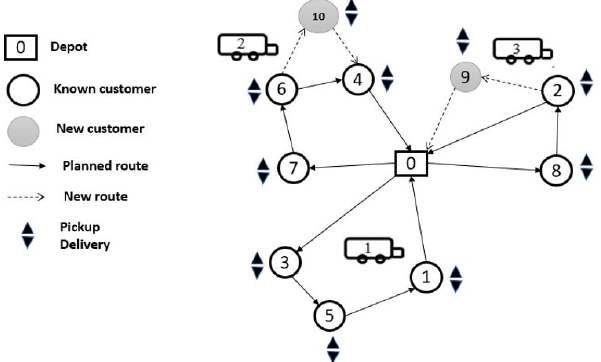
Fig. 1. Illustration of